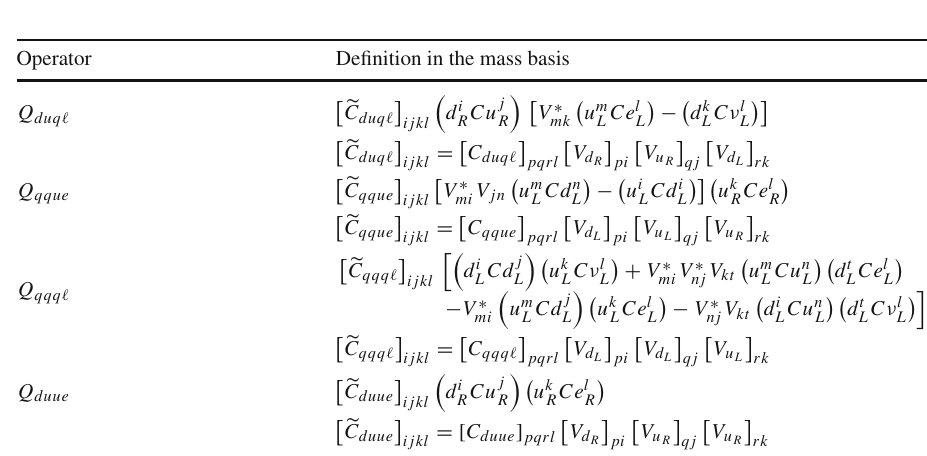
Baryon-number-violating operators in the mass basis